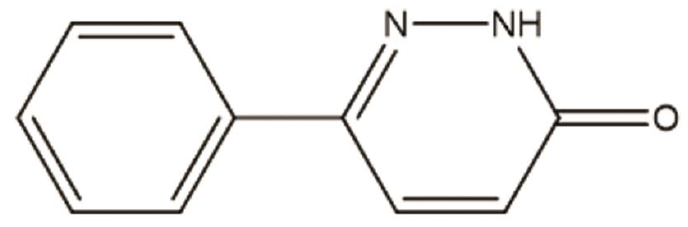
Figure 1. The molecular structure of PPD (molar mass: 172.18 g·mol − 1 ).